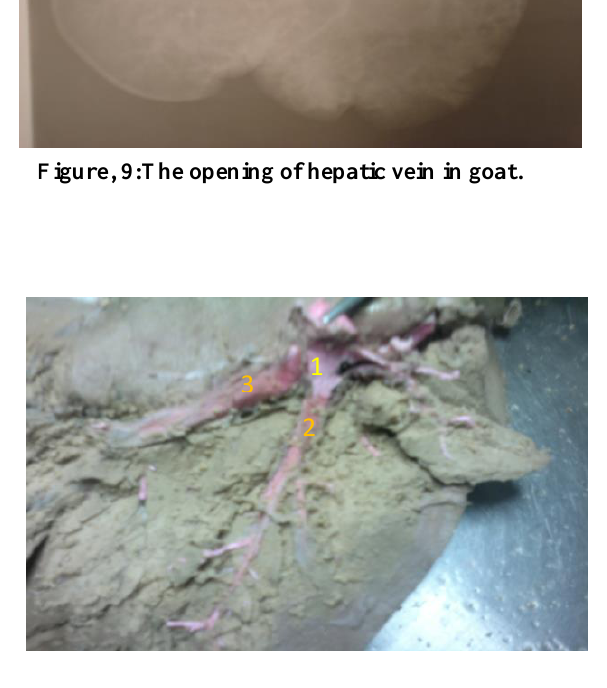
Figure, 11: The divisions of the hepatic vein into 1-right 2-intermediate left branches in sheep.